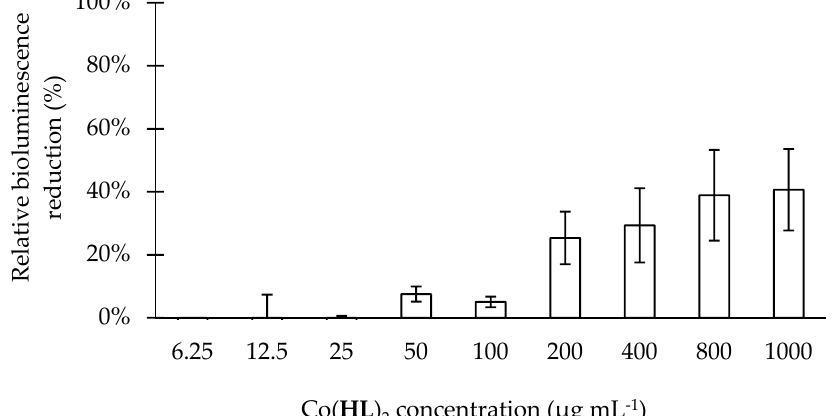
Figure 2. Effect of increasing concentrations of Co( HL ) 2 (6.25 to 1000 µg mL − 1 ) on the production of 3-oxo-C12-HSL by P. aeruginosa PA14 (wild-type strain) (bars) and quantification of the 3-oxo-C12-HSL produced levels (dashed line). Bioluminescence emissions were normalized to the cell density of the bacterial culture and expressed as percentages with respect to untreated controls (cells + DMSO at 6%; relative bioluminescence). 3-oxo-C12-HSL levels were expressed as percentages with respect to untreated controls (cells + DMSO at 6%; relative 3-oxo-C12-HSL). Mean values ± standard deviations for at least three replicates are illustrated.